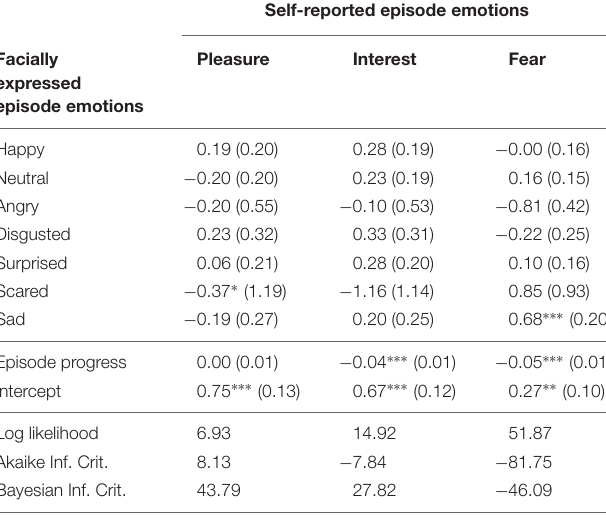
TABLE 5 | Standardized regression coefficients ( β ), standard errors (in parenthesis) and overall statistics for three models with self-reported episode emotions as dependent and facially expressed episode emotions as predictor